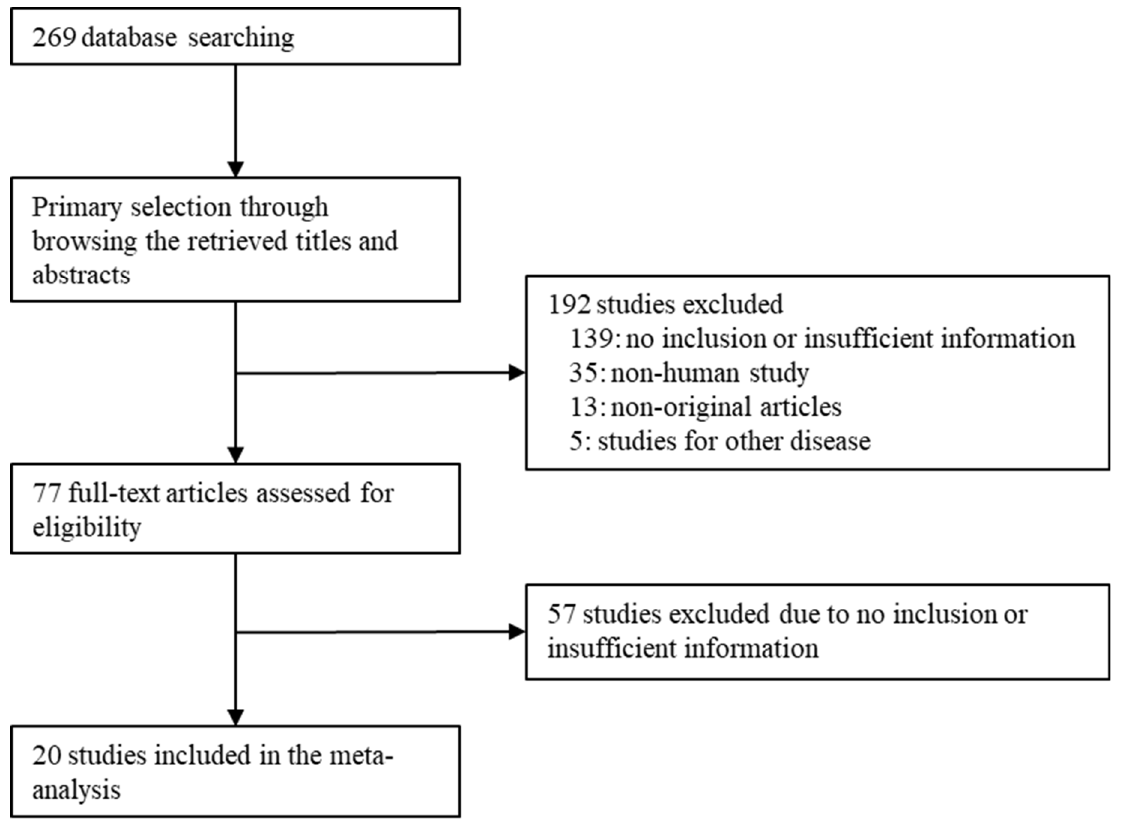
Figure 1. Flow chart showing the study search and selection methods. Table 1. Main characteristics of the eligible studies.